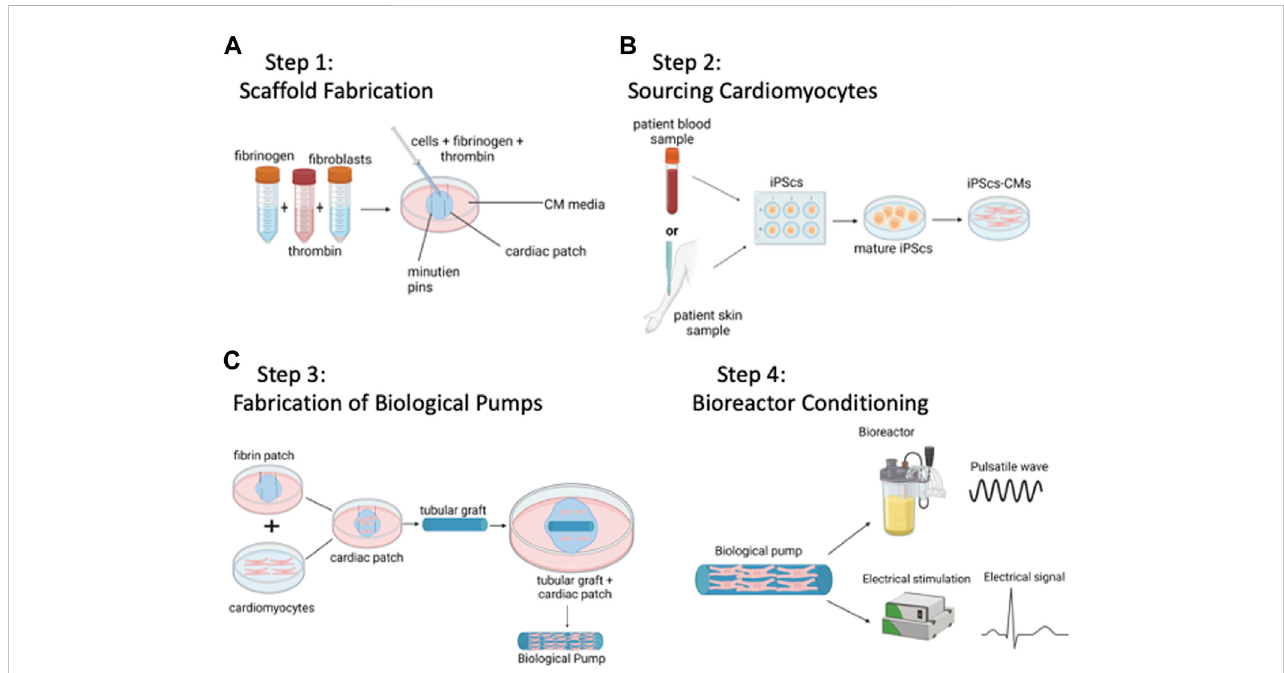
FIGURE 1 Method to Bioengineer Biological Pumps — (A) Step 1: Scaffold Fabrication. (B) Step 2: Sourcing Cardiomyocytes. (C) Step 3: Fabrication of Biological Pumps. (D) Step 4: Bioreactor Conditioning. Created with